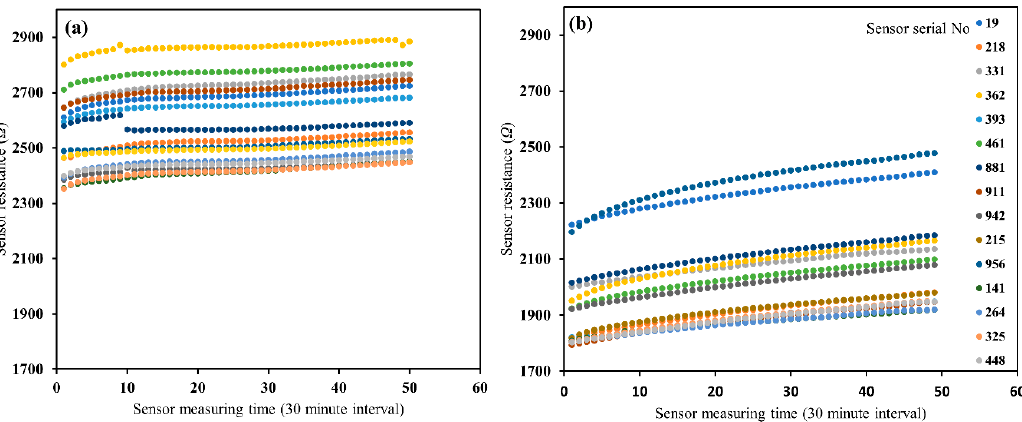
Figure 2. Comparison of 15 probes output resistance at 0.2 m 3 m − 3 water content with ~1 dS / m solution of electrical conductivity in ( a ) glass beads and ( b ) Oso Flaco sand, over 24 h.